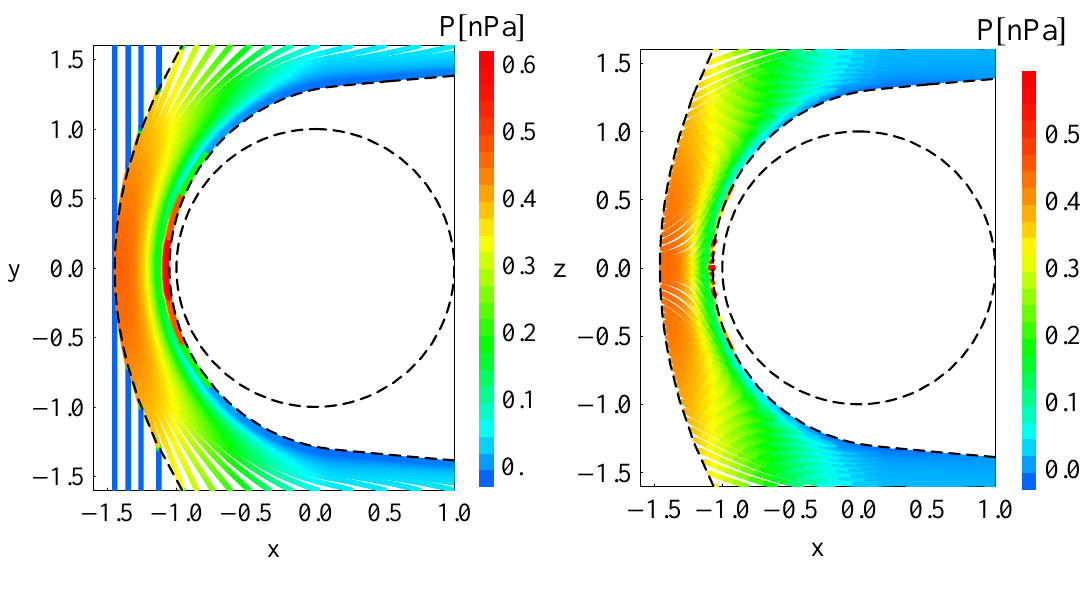
Fig. 8. MHD model: Distribution of the plasma pressure in xy plane (left) and in xz plane